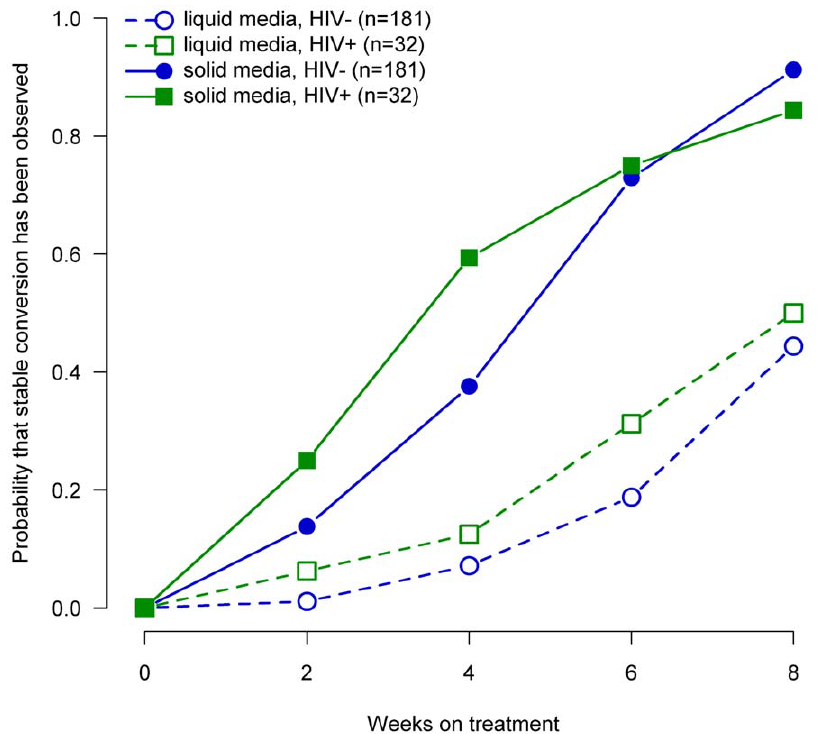
Figure 6. Probability of sputum culture conversion among African patients by HIV status by media type and week of treatment, TBTC Study 28 protocol-correct patients.